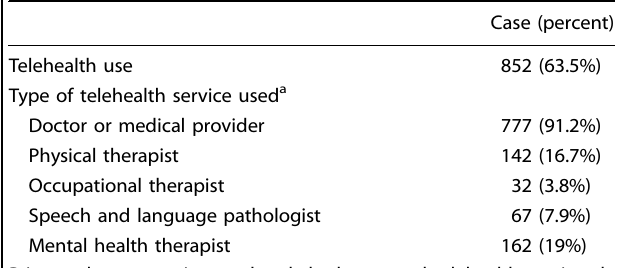
Table 2. Telehealth use characteristics in people with Parkinson ’ s